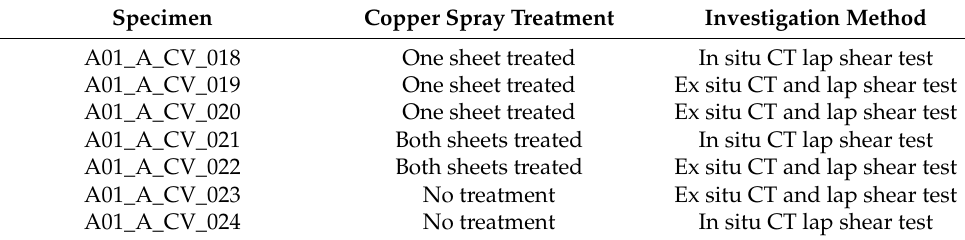
Table 2. Specimen overview.